Question: Judging by this figure, is the value going up or going down?
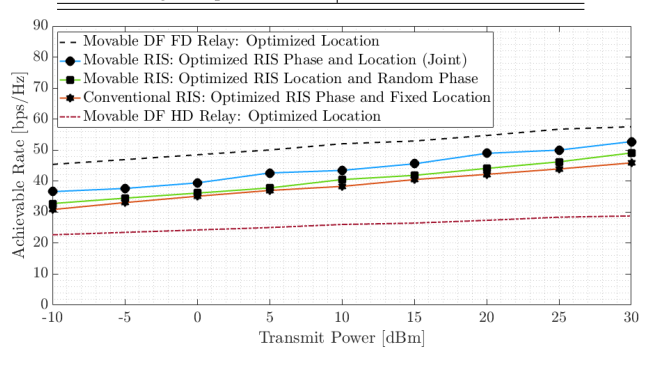
Answer: increasing